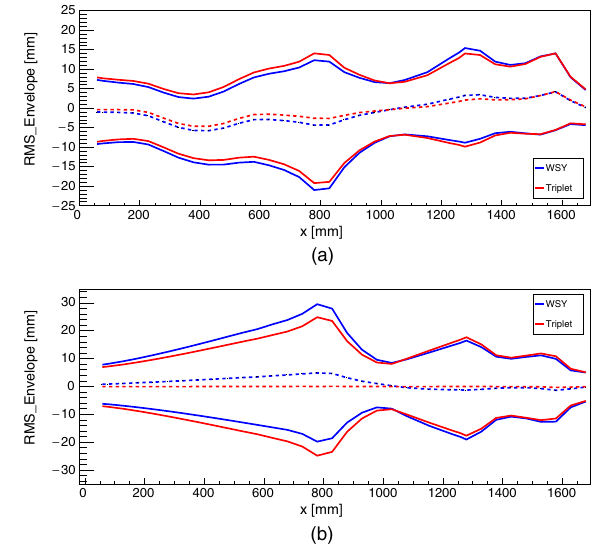
FIG. 21. Comparisons of (a) horizontal and (b) vertical rms (solid lines) and center (dashed lines) of the beam for the 15-keV muon beam under the influence of different stray fields along the EM-S beam